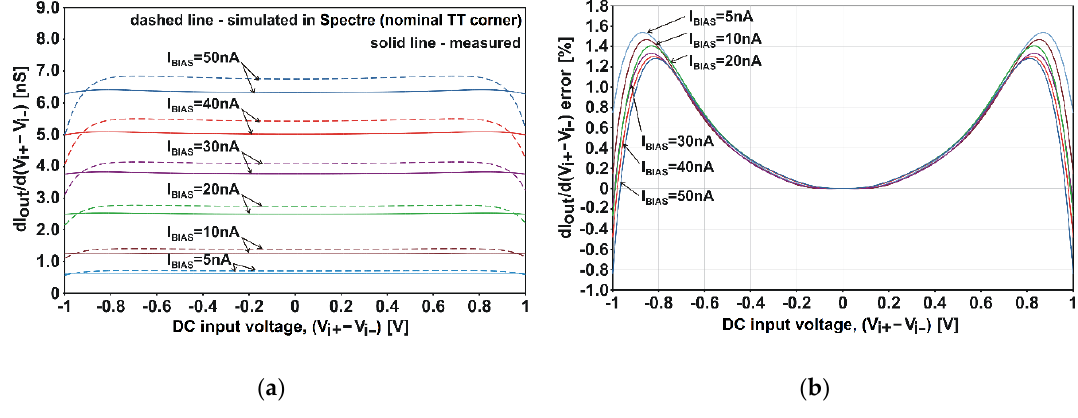
Figure 7. DC characteristics of the amplifier of Figure 3 at the symmetrical input drive: ( a ) derivatives d I out / d( V i + − V i − ); ( b ) deviation error of the measured d I out / d( V i + − V i − ) plots (i.e., deviation error of G m,diff ). V DD is 1 V and T is 27 °C.